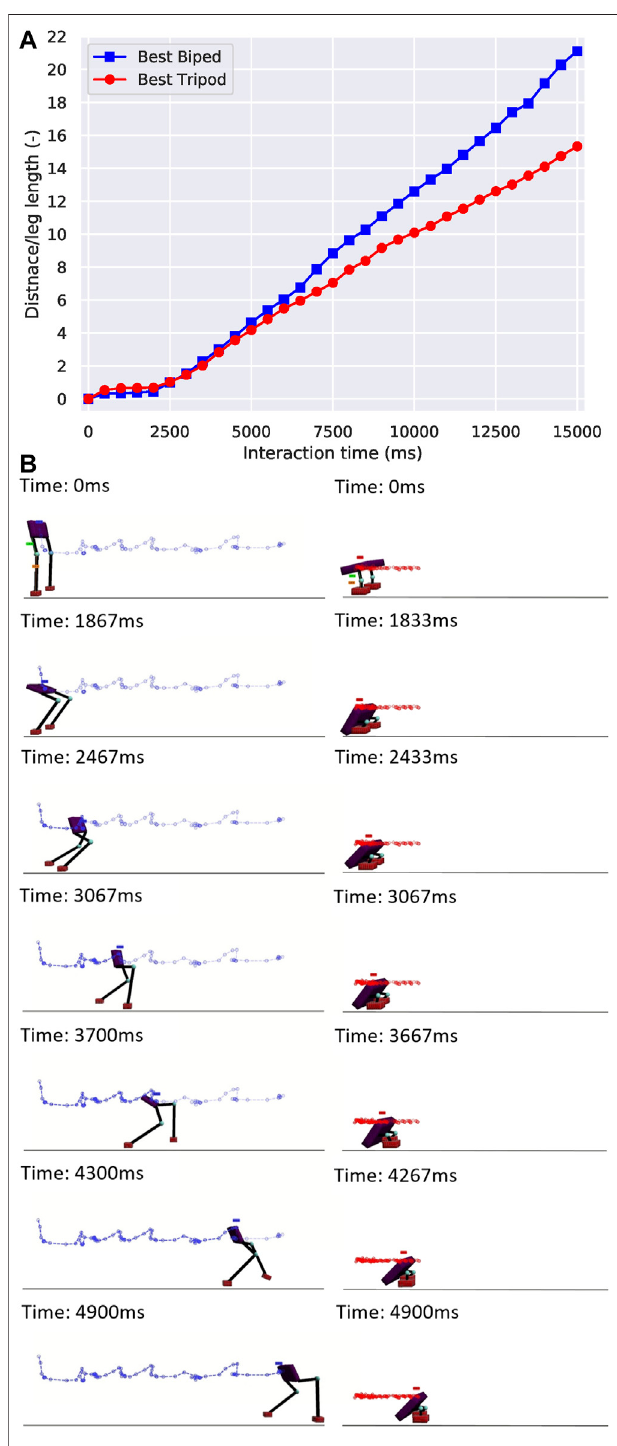
FIGURE 4 | The fi tness and snapshotsof the best biped and best tripod creatures. (A) Fitness of the best biped and best tripod creatures over a 15 seconds interaction time, which is the creature interacting with the simulation environment per generation. The best biped has a femur length of 0.36 m and a tibia length of 0.81 m, while the values for the best tripod are 0.20 and 0.21 m. (B) The trajectory is generated by the motion analysis, with blue and red lines showing the path of the center of the body.